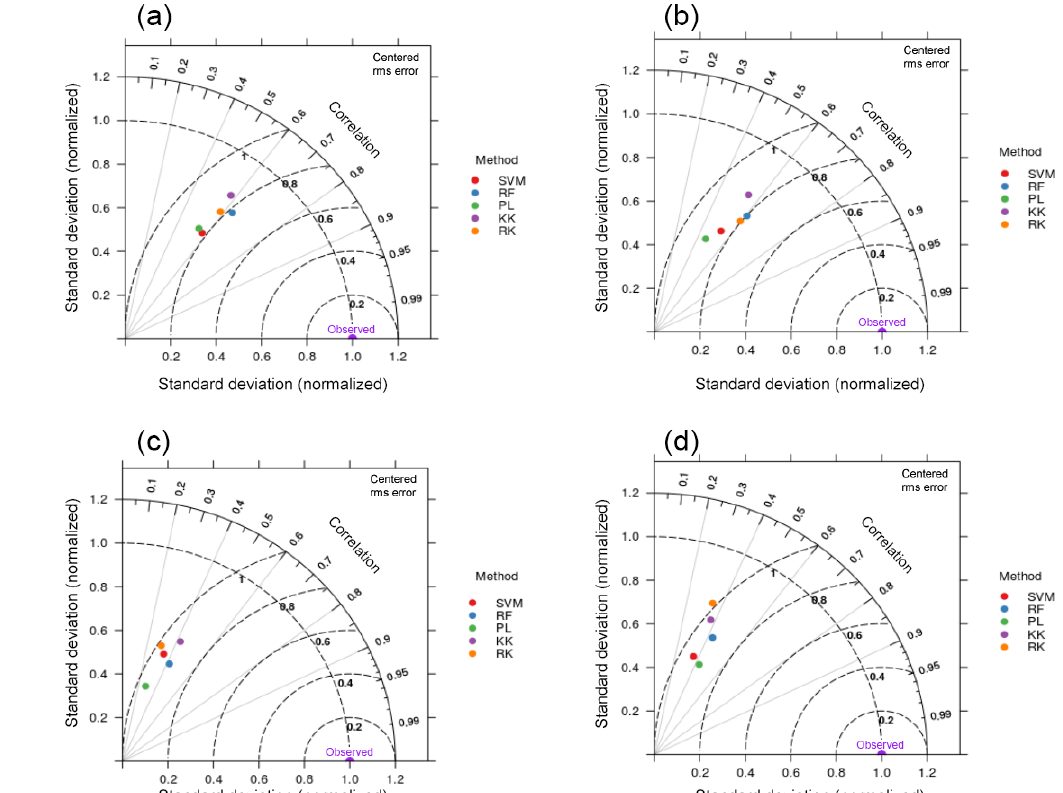
Figure 3. Taylor diagrams showing the performance of the five models evaluated. SOC stock (a) , ORCDR (b) , BLD (c) , and CRFVOL (d) . This analysis is based on all available data across Latin America. Although RF tends to generate higher correlation, it also shows high variance in predictions. The points are close to each other and the differences in accuracy between them generally fall within the same intersection of error, variance, and correlation, suggesting a similar prediction capacity by the implemented